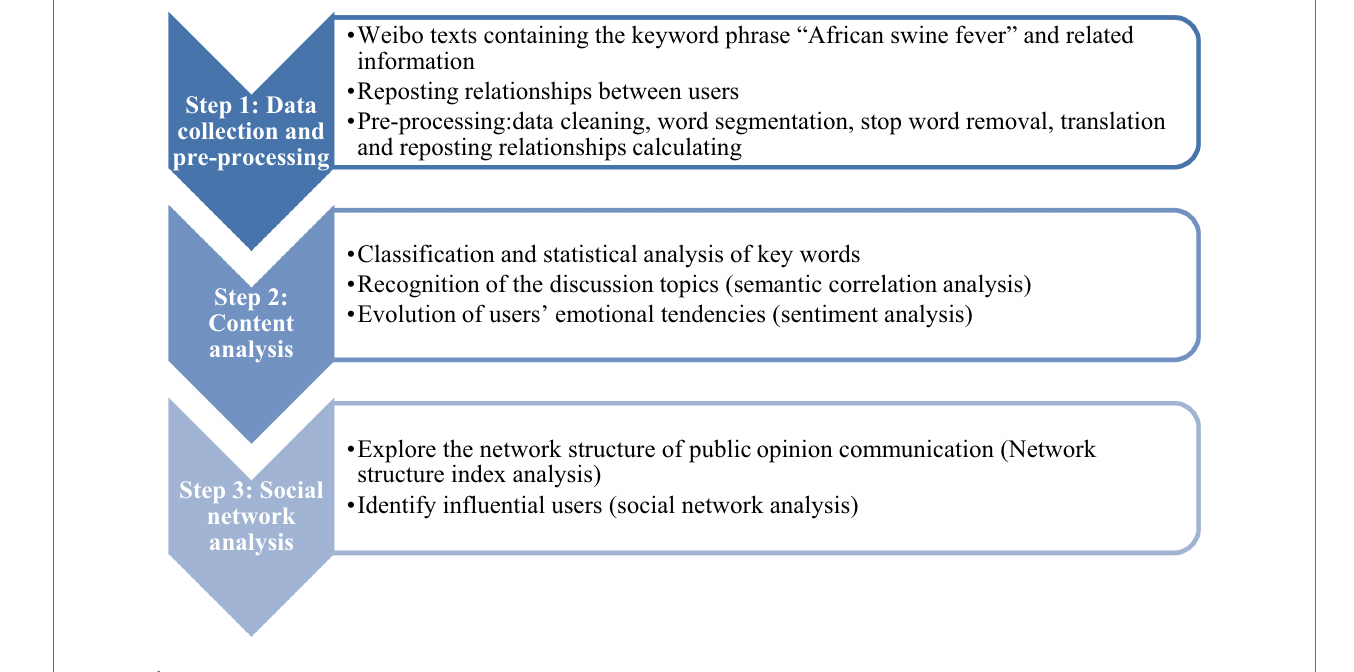
FIGURE 3 | Framework for the ASF social media